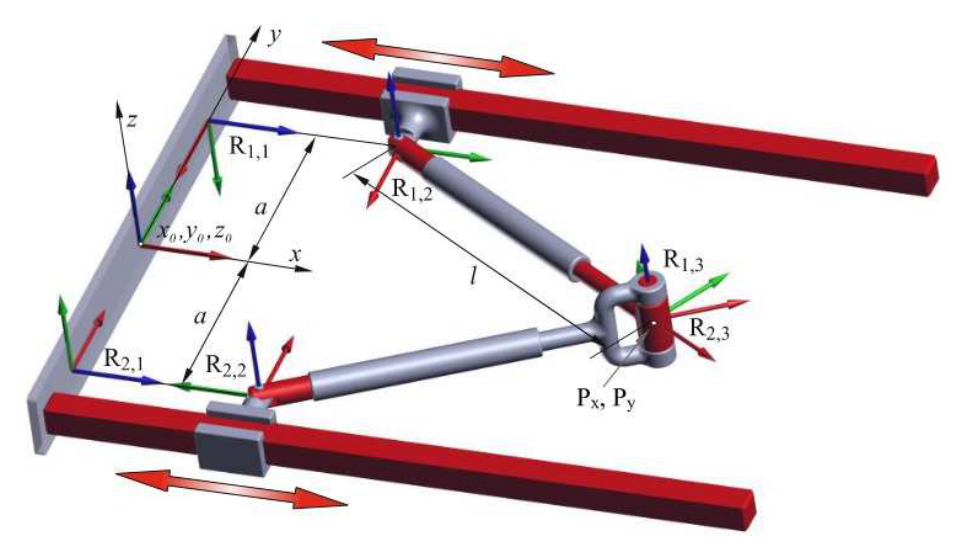
Figure 4. A model of a plane manipulator with two degrees of freedom with designations of parameters for the kinematic model (source: [8]).